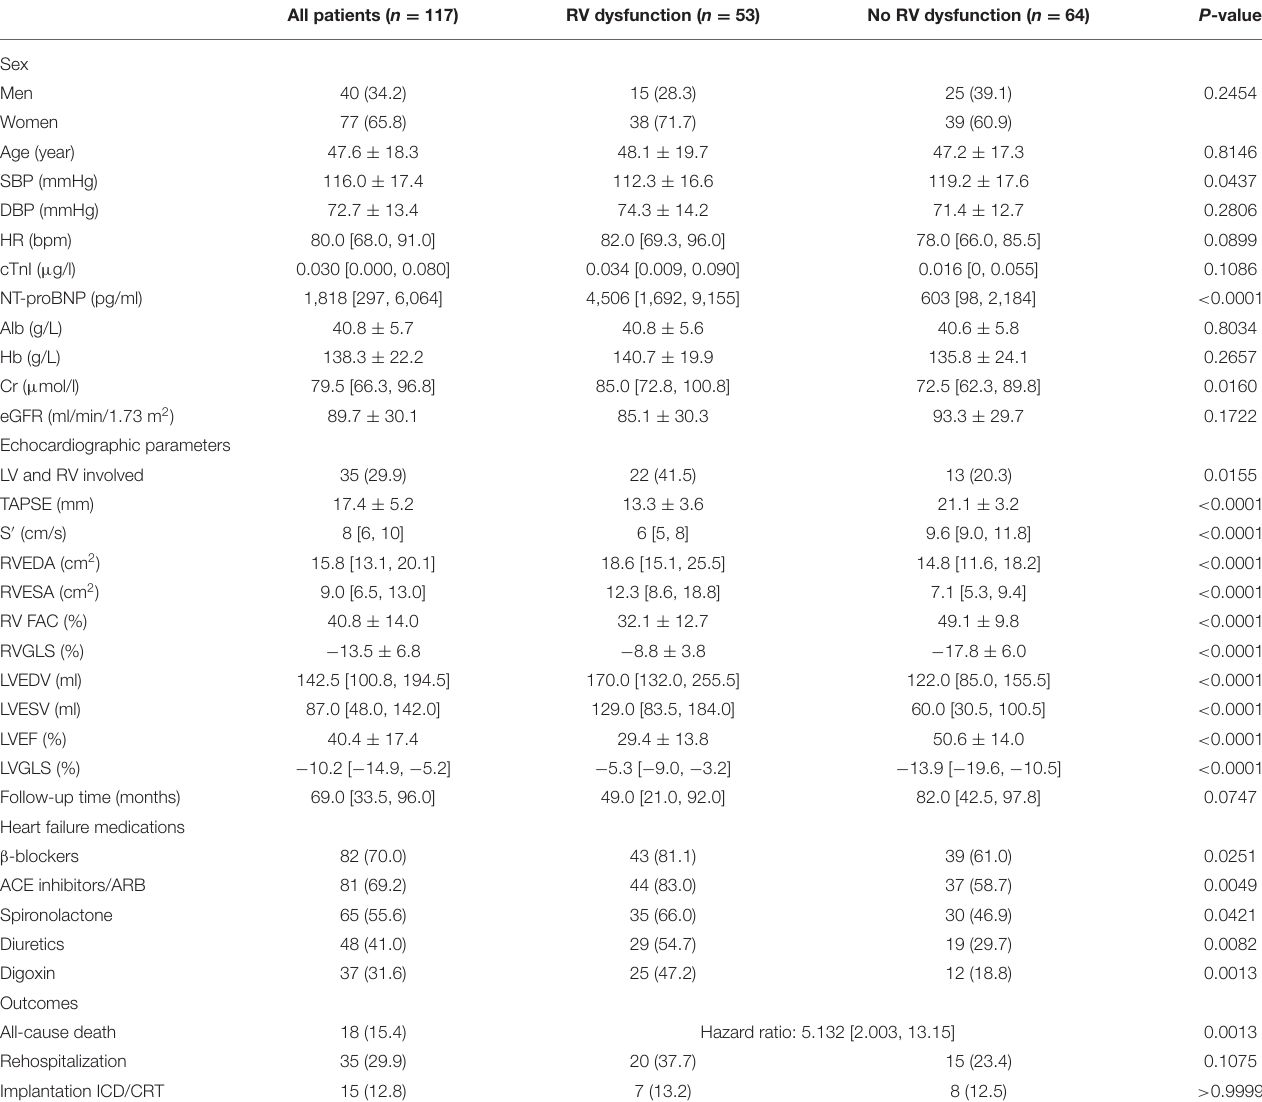
TABLE 1 | Characteristics and outcomes of all patients. All patients ( n =